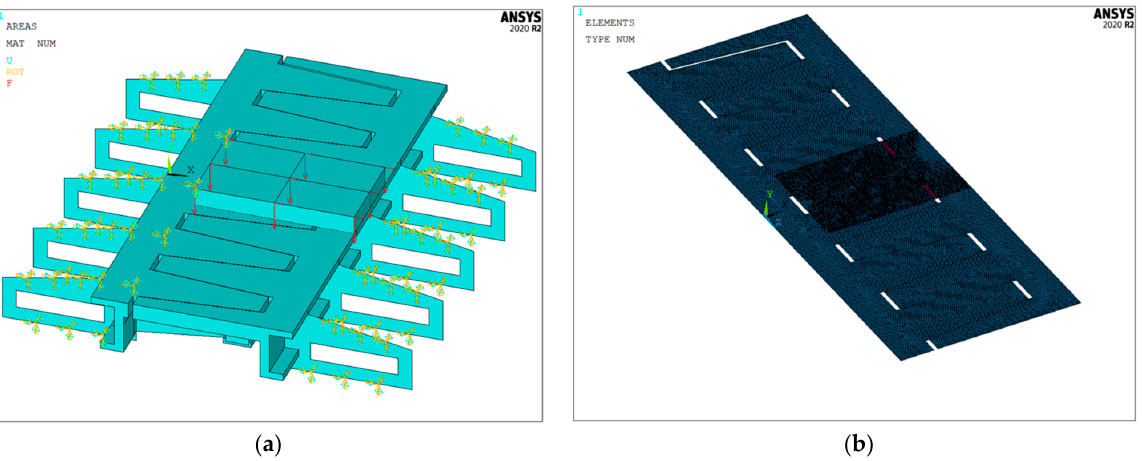
Figure 3. The finite element modelling for a working condition I: ( a ) FEM of comb plate expansion, ( b ) The contact pair.